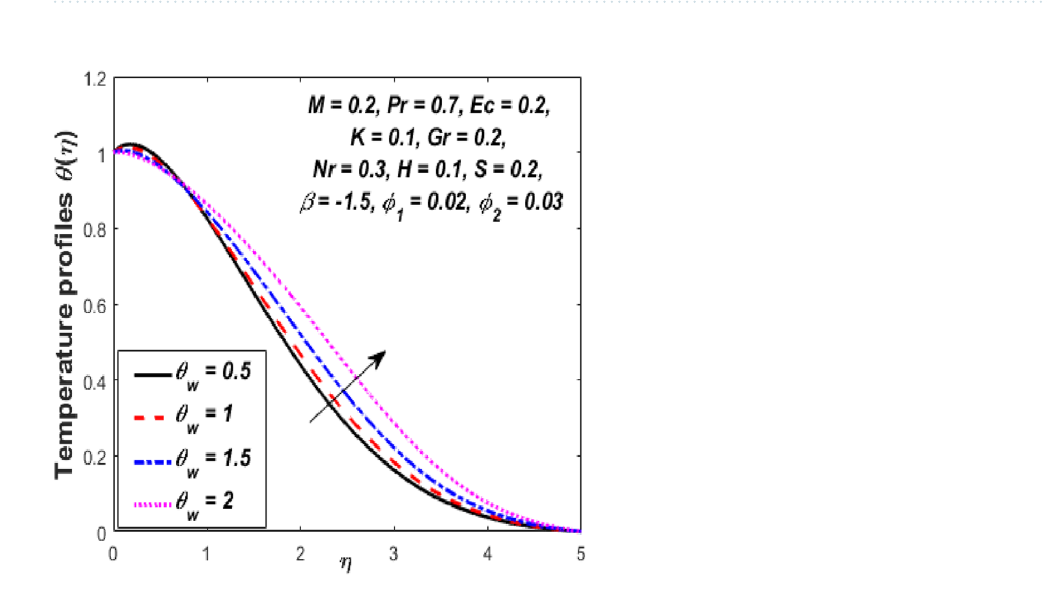
Figure 10. Influence of θ w on temperature θ(η)